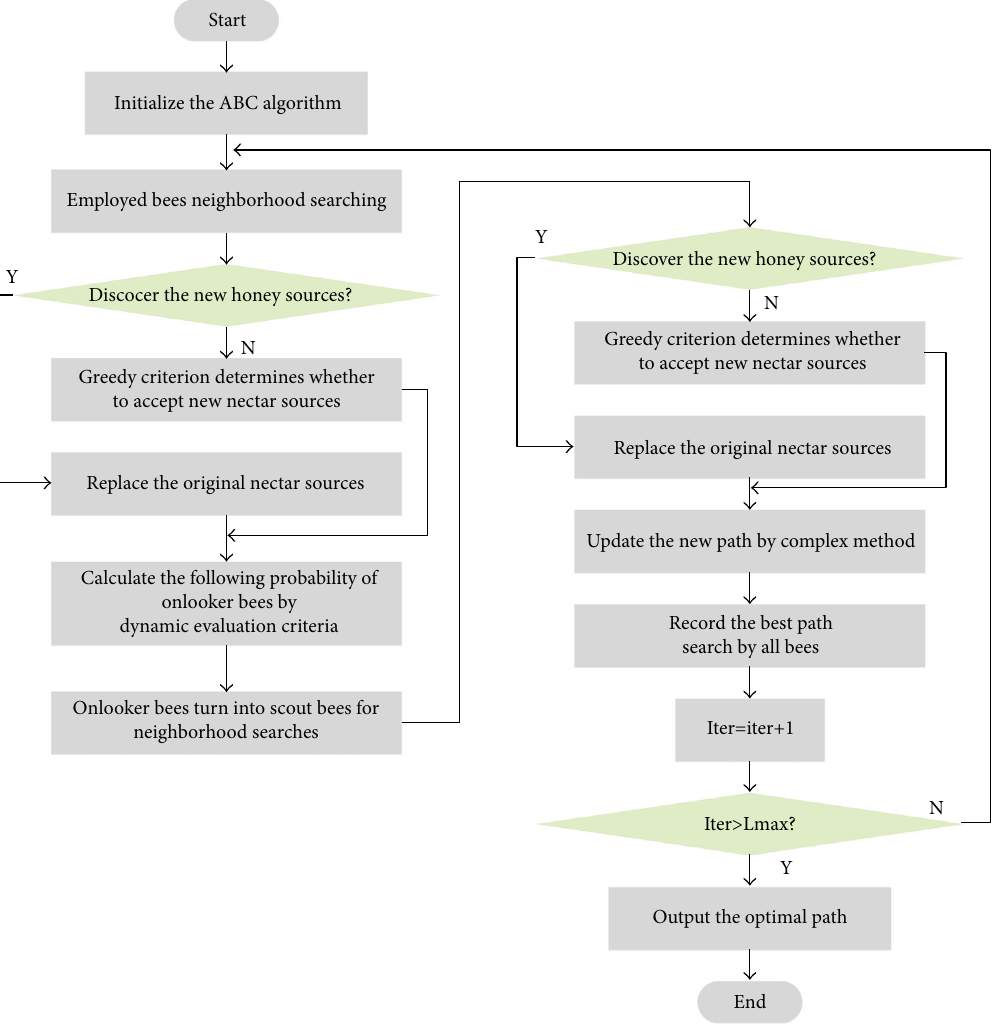
Figure 7: Flow diagram of the